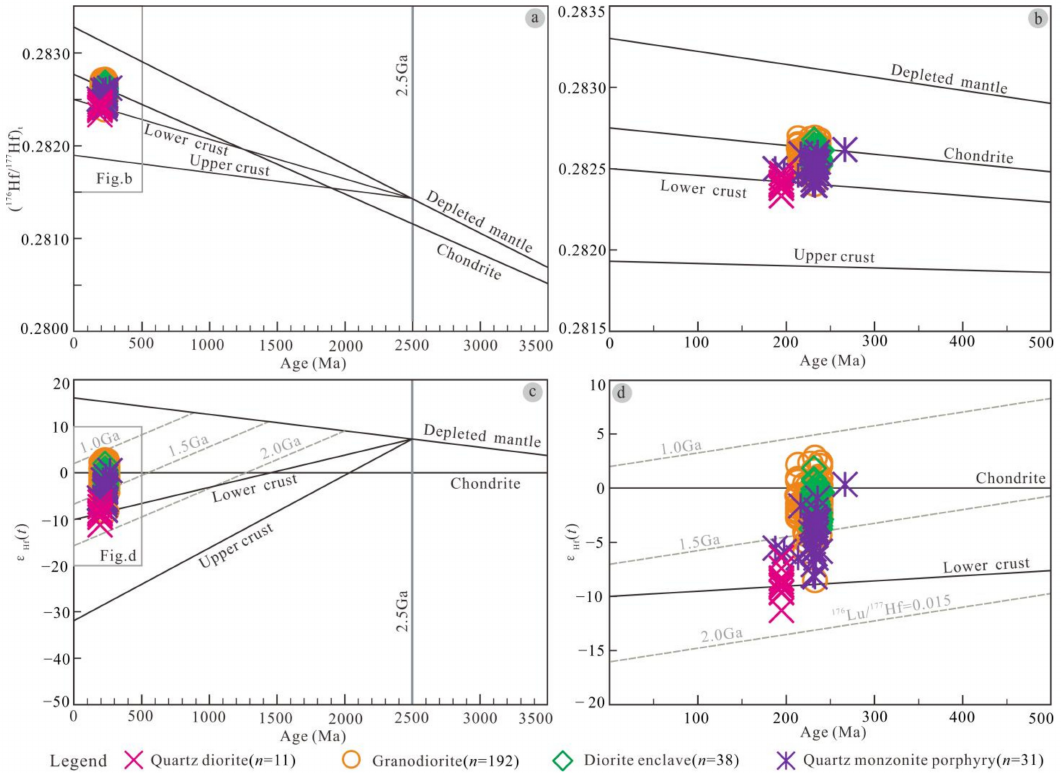
Figure 13. Hafnium isotopic compositions and zircon U-Pb ages plots from Yangla granitoid intru- sions. ( a , b ) 176 Hf/ 177 Hf vs. zircon U-Pb age; ( c , d ) ε Hf ( t ) vs. zircon U-Pb age. The Yangla